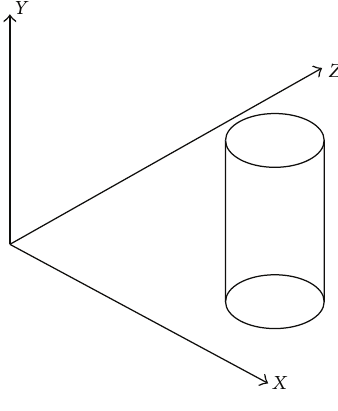
Figure 3: Target geometry.